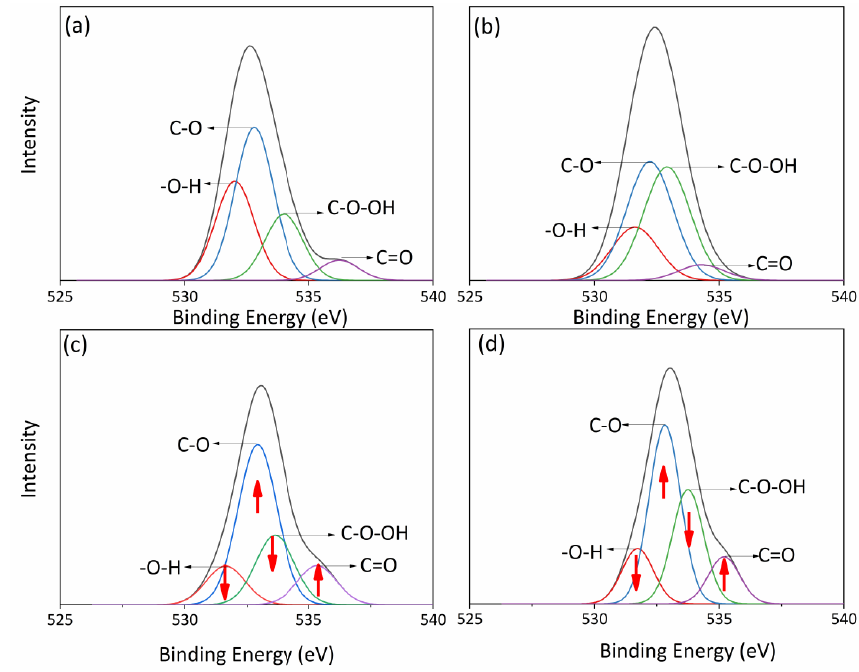
Figure 5. High-resolution XPS O 1s spectra of pre- and post-adsorption for ( a , c ) humic acid and ( b , d ) struvite – humic acid composite.